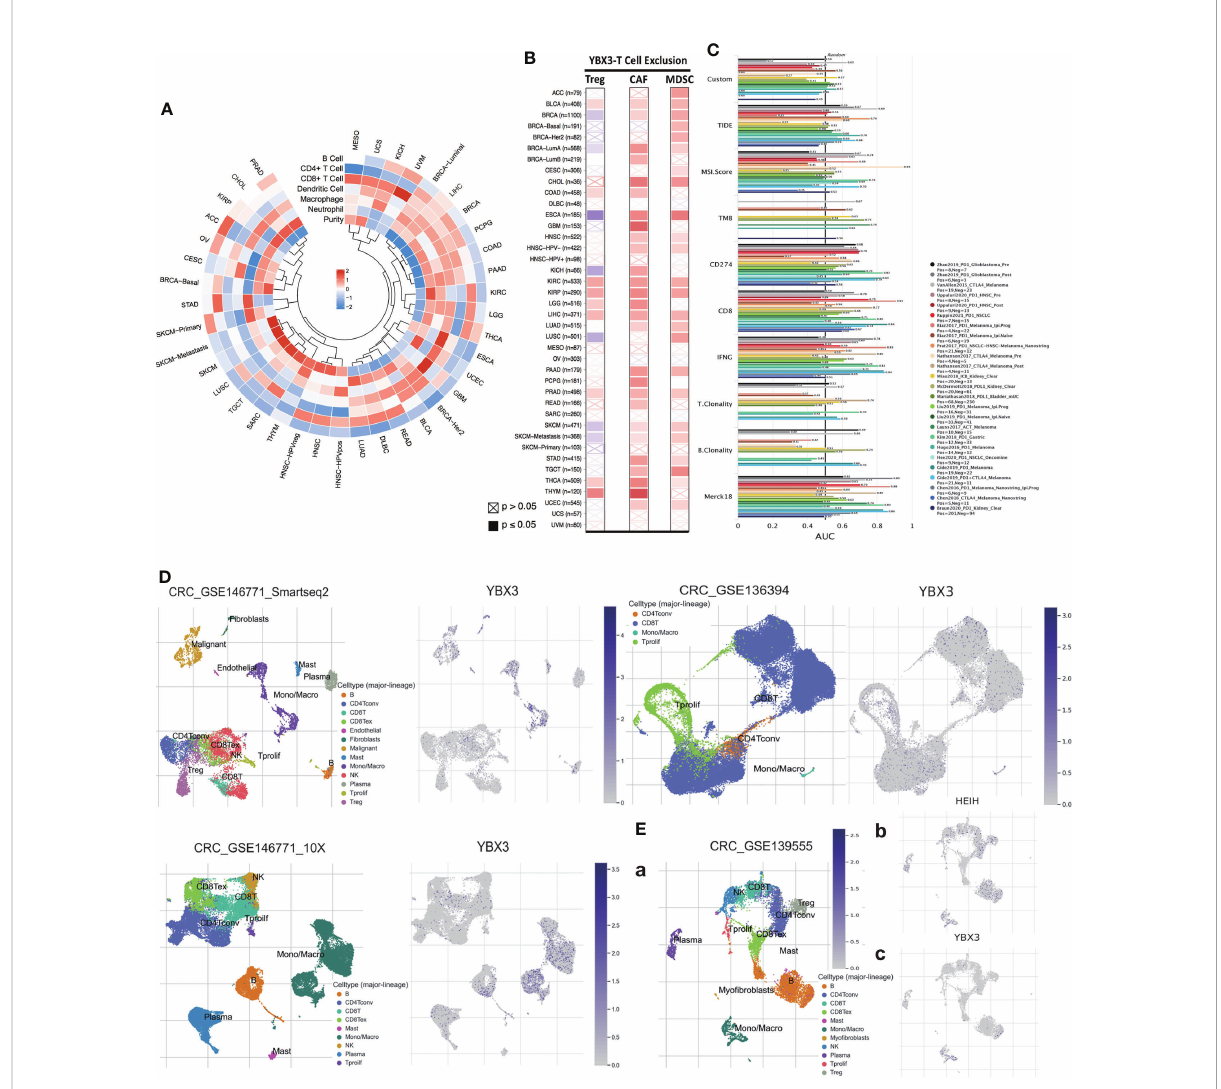
FIGURE 6 Impact of YBX3 expression on immune/immunosuppressive cells across The Cancer Genome Atlas (TCGA) cancers and on the biomarker value of ICB sub-cohorts and YBX3 expression pro fi le in different immune cells. (A) Correlations between YBX3 expression and in fi ltration of six immune cell types across all cancer types in TCGA cohorts. (B) Correlations of YBX3 expression with three immunosuppressive cell types in various TCGA cancer types. (C) Biomarker relevance of MXD3 compared to standardized cancer immune evasion biomarkers in immune checkpoint blockade sub-cohorts. (D, E) Presenting YBX3 and HEIH expression pro fi le in different immune cells using scRNA-seq data from GEO